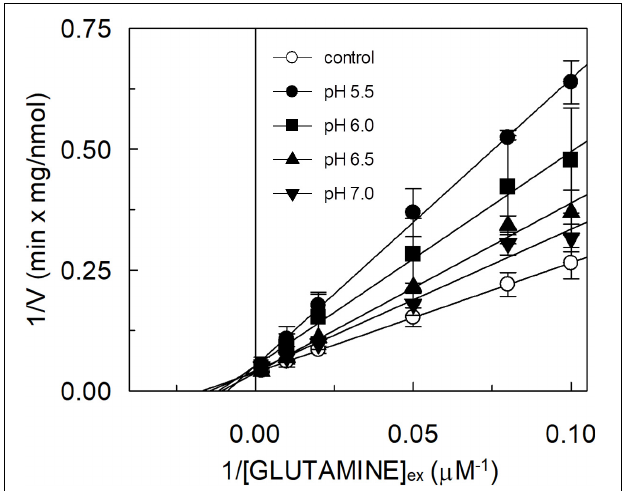
FIGURE 2 | Effect of glutamate on the kinetics of glutamine transport by hASCT2 reconstituted in proteoliposomes. Purified hASCT2 was reconstituted in proteoliposomes prepared at the indicated pH and containing 10 mM glutamine, as described in materials and methods. The transport was started by adding indicated concentrations of [ 3 H]glutamine and 50 mM Na-gluconate to proteoliposomes in the presence of 5 mM glutamate buffered at different pH: pH 5.5 ( • ), pH 6.0( (cid:4) ), pH 6.5 ( (cid:78) ), pH 7.0 ( (cid:72) ). The control condition ( ◦ ) represents a mean of [ 3 H]glutamine measurements at the different pH (5.5, 6.0, 6.5, and 7.0) being Km for glutamine not affected by pH variations. The transport was measured in 15 min according to the stop inhibitor method. Data were plotted according to linear Lineweaver–Burk equation as reciprocal transport rate vs. reciprocal glutamine concentration. Results are means ± SD from three independent experiments.